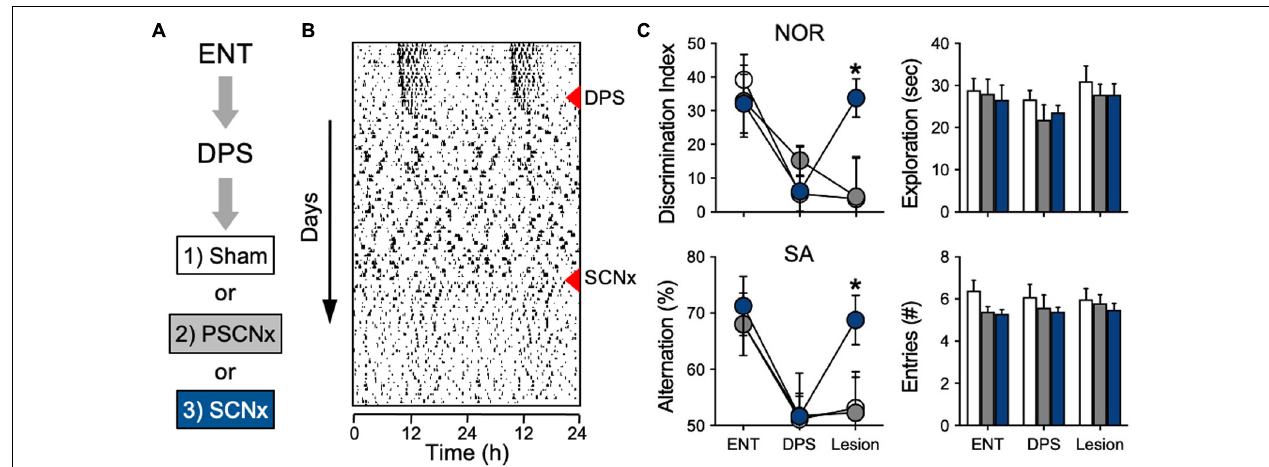
FIGURE 4 | SCN lesions rescue object recognition and spatial memory in DPS hamsters. (A) Sequence of experiment stages. ENT hamsters performed the NOR and SA tasks, followed by exposure to the DPS protocol (red triangle). 4 weeks later, arrhythmic animals underwent SCN ablation or Sham surgeries (red triangle). (B) Representative actogram of an SCNx animal; memory tasks were performed at the end of each experimental stage. NOR task used a 24-h interval between sample and test phases. (C) Memory was rescued only in animals with complete SCN ablation (blue circles). No differences were found in NOR exploration times or in SA arm entries; all tests were performed within 3 h before dark onset. Figure modified from Fernandez et al.